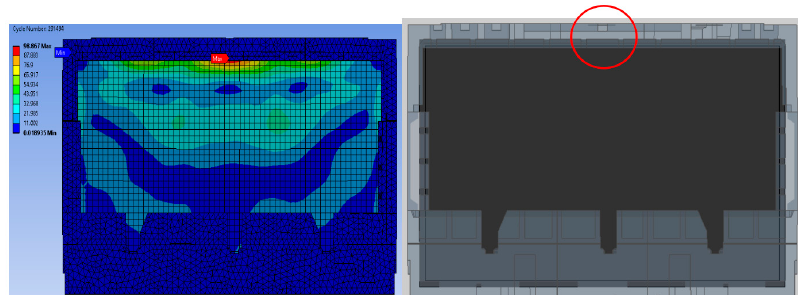
Figure 10. Analysis result of model B.